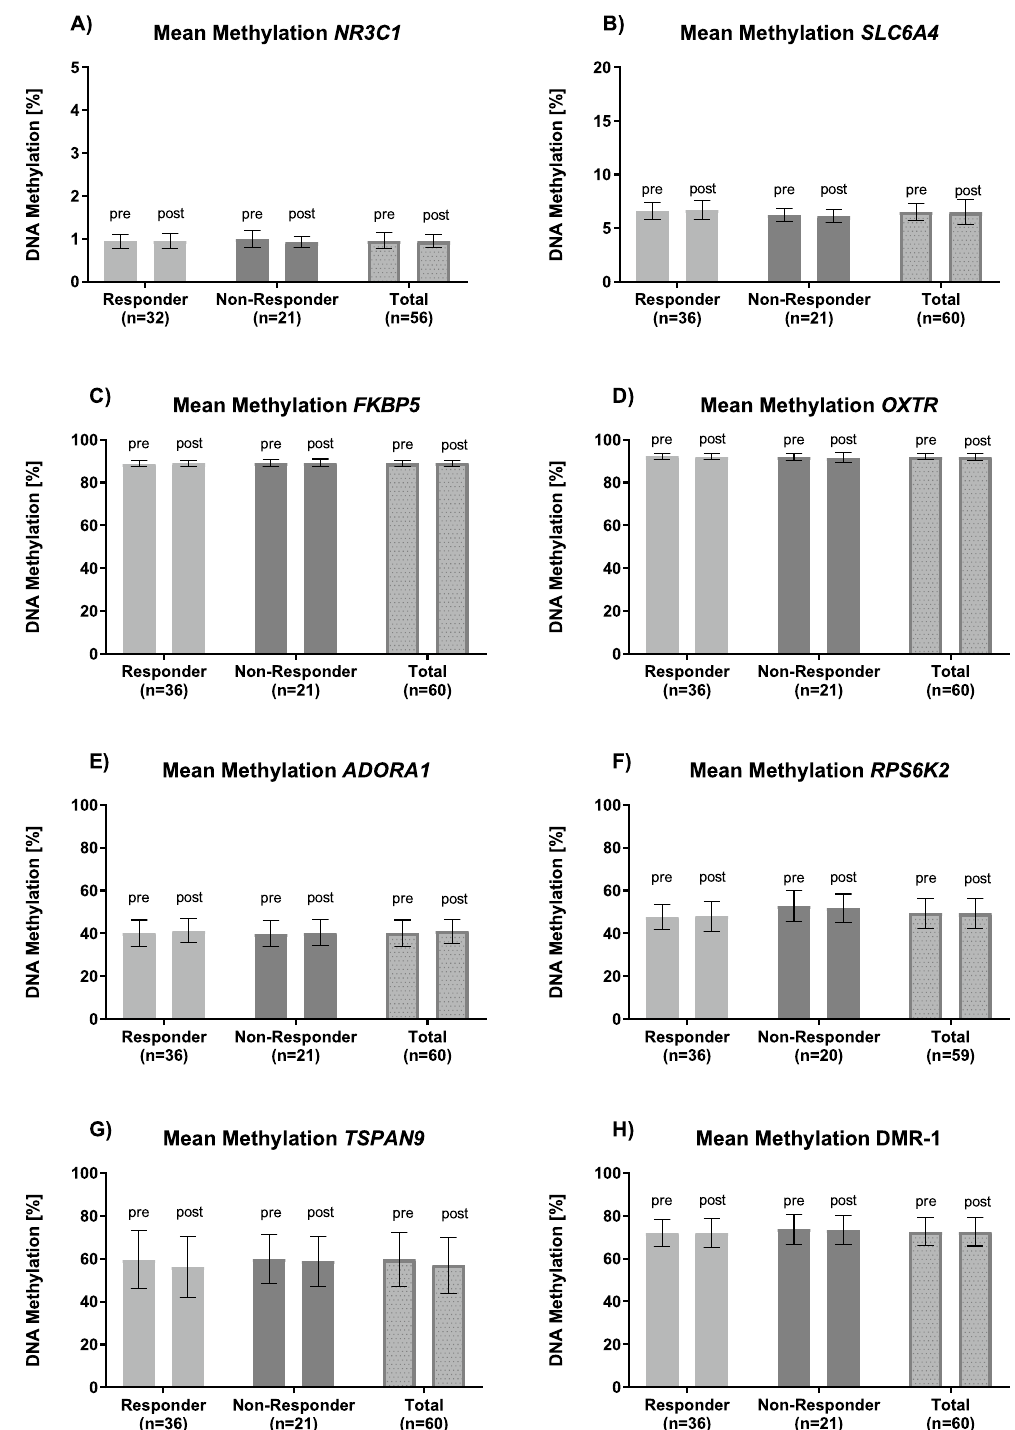
Figure 2. Mean DNA Methylation of the PTSD cohort. Mean DNA methylation values in percent (%) of candidate genes ( A–D ) and new targets from WGBS ( E–H ) pre-and post-intervention for responders, non- responders and the entire cohort are